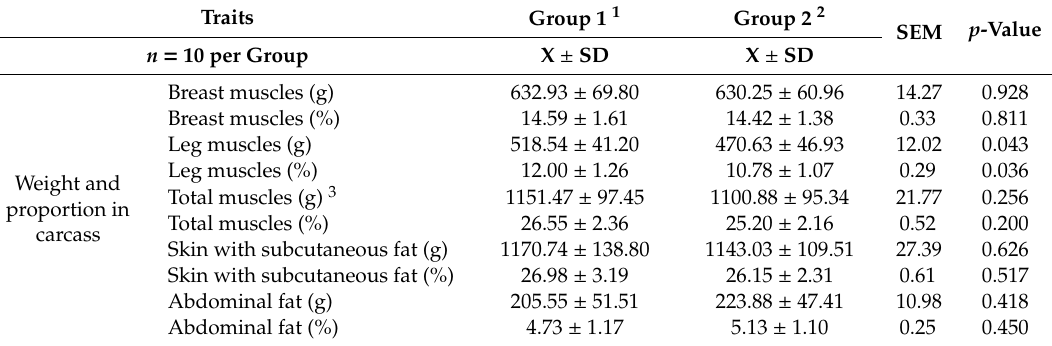
Table 5. Muscles and fat (mean; ± SD; SEM) in 16-week-old